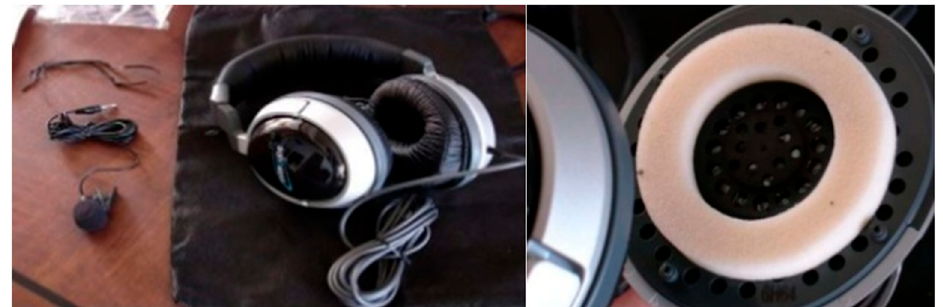
Figure 19. Biocellulose as membrane transducer in Sony headphones [221].